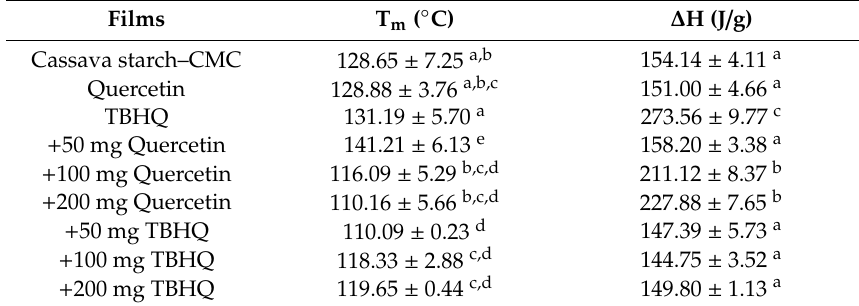
Table 1. Melting temperature (T m ) and heat of fusion ( ∆ H) of cassava starch–CMC films incorporated with varying concentrations of quercetin (Q) and TBHQ